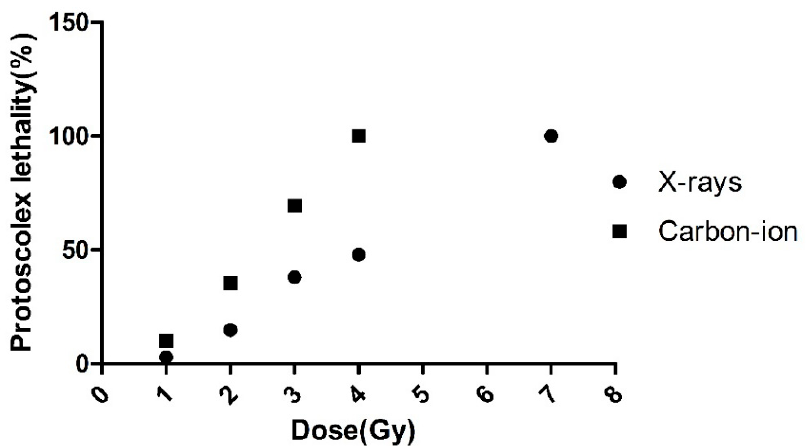
Figure 1. Percent lethality versus radiation dose. The data are fitted to a sigmoidal dose response function: y = a + b/(1 + exp( − (x( − c)/d)), where y is the percent lethality, x is the dose in Gy, respectively.